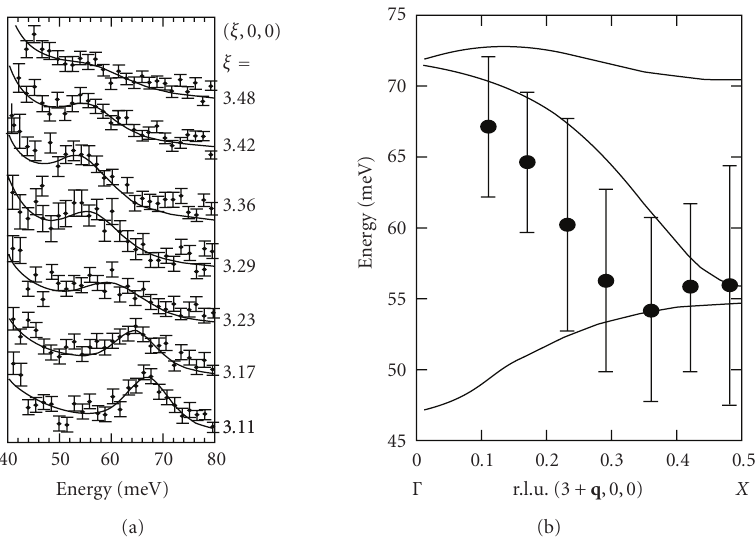
Figure 26: Bond stretching phonons in HgBa 2 CuO 4+ x (from [77]). (a) Enlarged spectra taken close to the bond stretching mode plotted on a linear scale. (b) Data points represent frequencies of the bond-stretching phonons. The lines show the shell model calculation in which the interaction between the next-nearest neighbor oxygens in the CuO 2 plane is added. The lines indicate (top to bottom) the c -polarized apical oxygen mode, the a -polarized Cu–O bond stretching mode, and the a -polarized in-plane Cu–O bending mode, respectively. The vertical bars indicate the FWHM of the peaks determined in fitting data shown in